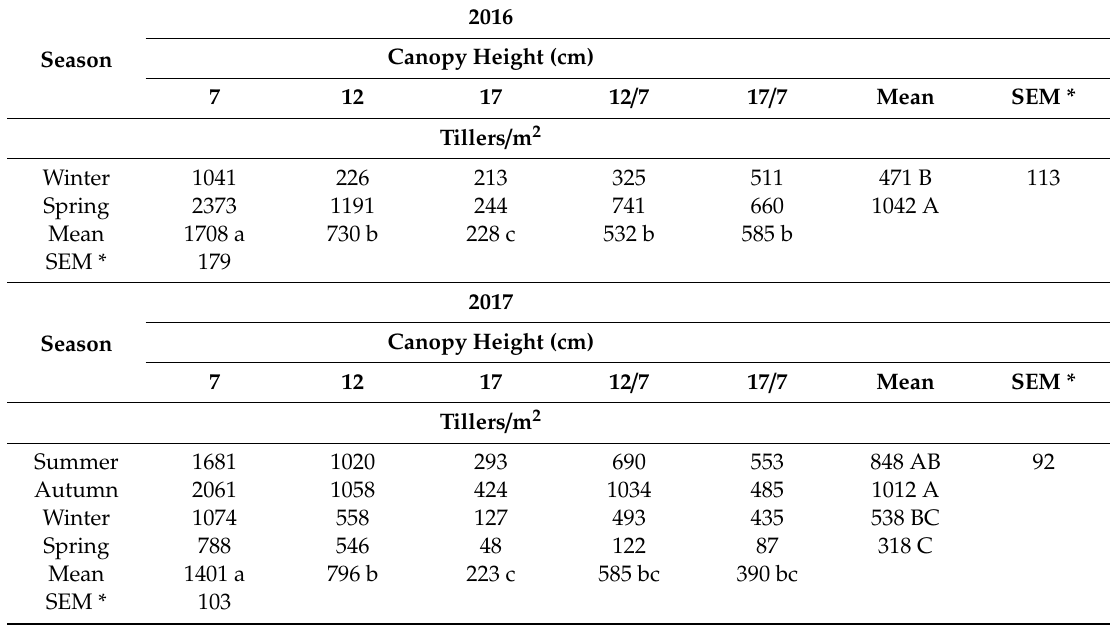
Table 2. Absolute number of emerged tillers of kikuyu-grass (tillers / m 2 ) in mixed canopies of kikuyu-grass and tall fescue submitted to grazing, in di ff erent seasons.